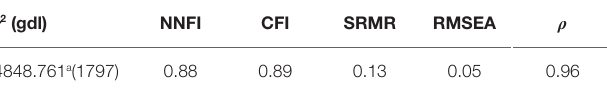
TABLE 9 | Fit indices model – creativity outcome.